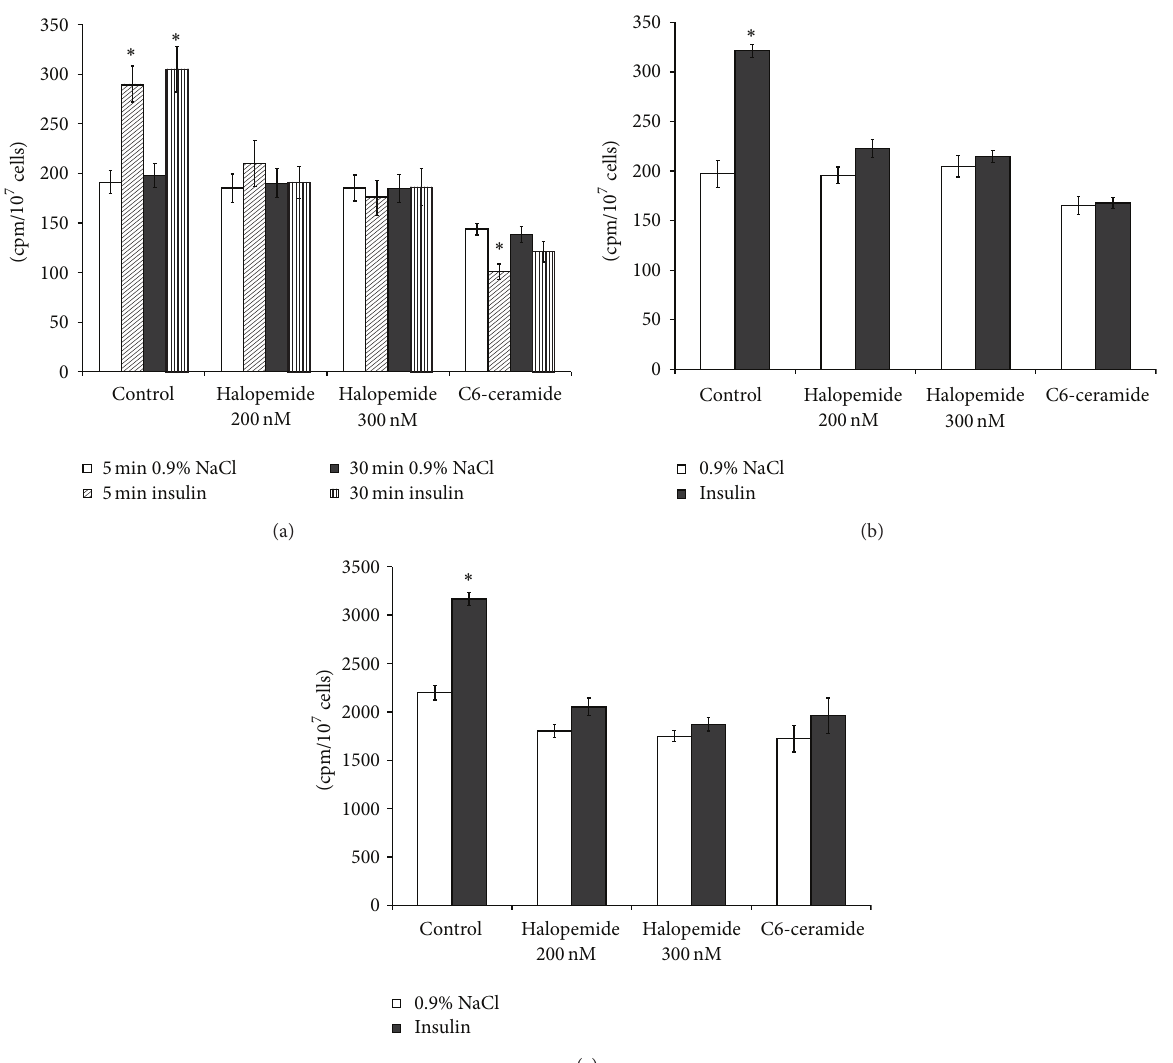
Figure 6: Effect of halopemide and ceramide on phospholipase D activity and glucose metabolism stimulation by insulin in the isolated hepatocytes. (a) Phospholipase D activity, (b) uptake of 2-D-[ 3 H]glucose, (c) incorporation of D-[U 14 C]glucose into glycogen. Effect of insulin on phospholipase D activity and glucose metabolism in the halopemide or C6-ceramide-pretreated hepatocytes was determined as described in the Methods. ∗ 𝑝 < 0.05 , insulin versus control; ∗∗ 𝑝 < 0.05 , insulin + drug versus insulin; ∗∗∗ 𝑝 < 0.05 , C6-ceramide in basal condition versus basal condition, control